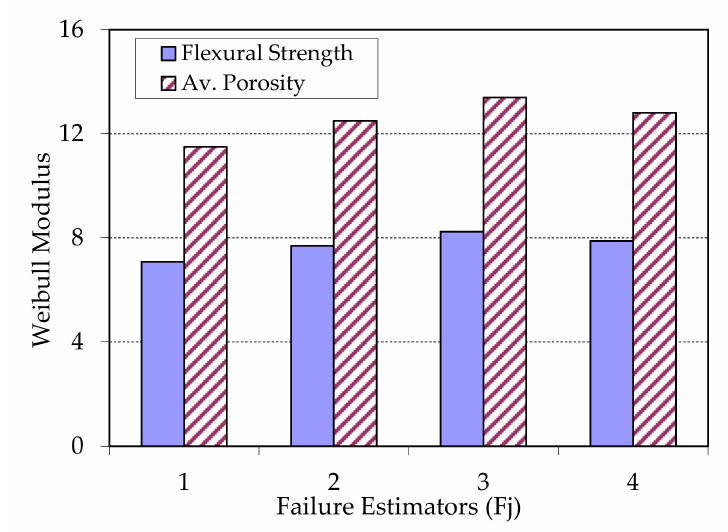
Figure 14. Weibull modulus vs. chosen estimators (Fj = 1 to 4) samples type G2 and for